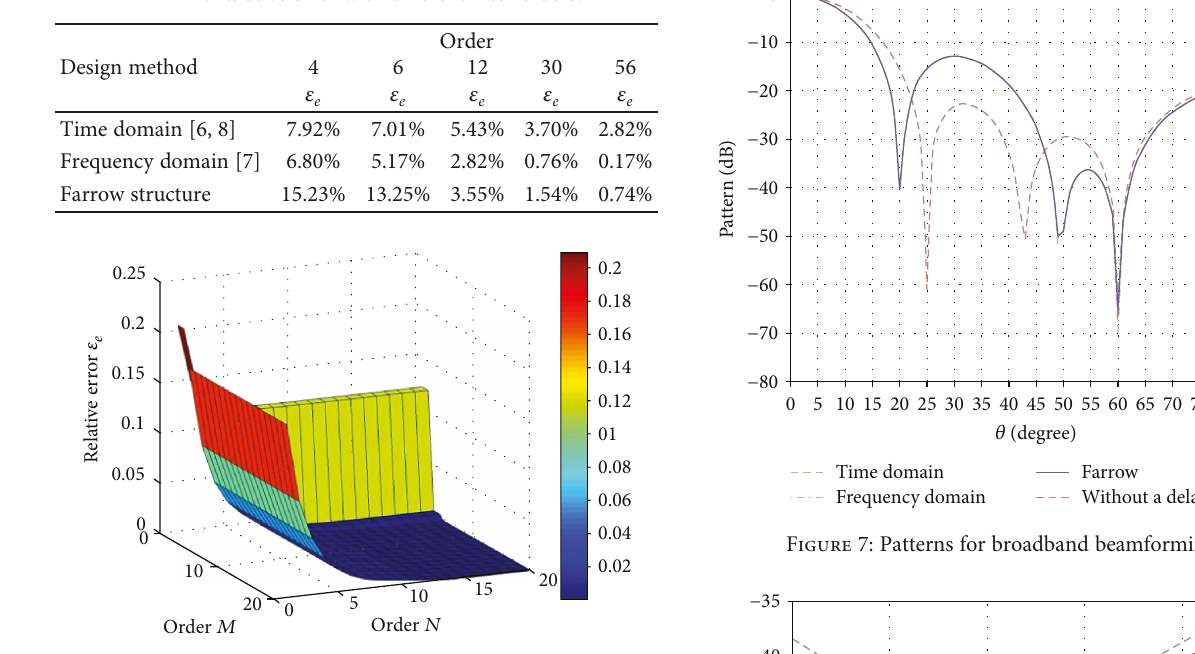
Figure 6: Error of the proposed Farrow fi lter with the order MN . Table 2: Comparison of computational complexity.